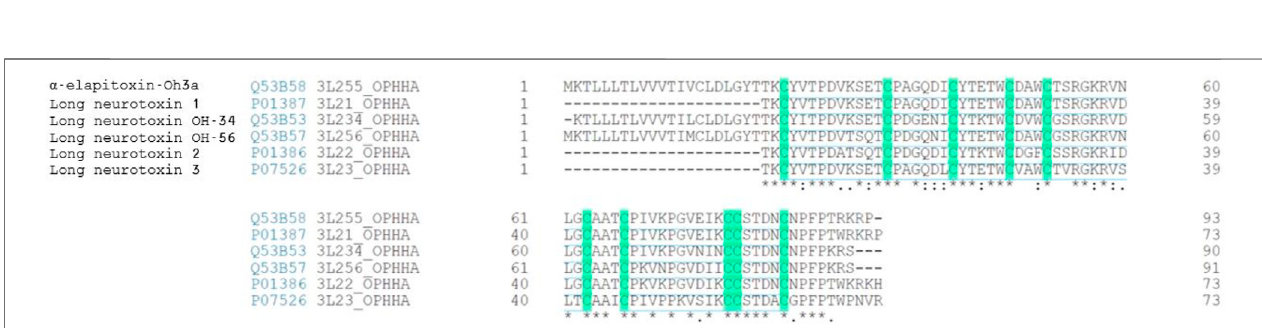
FIGURE4| Sequencealignment(fromBLASTsearch)of α -Elapitoxin-Oh3awithlong-chainalphaneurotoxinsfrom O.hannah venom.Highlightedaminoacidsare the 10 cysteine residues present in identical positions of all long-chain alpha neurotoxins that make the fi ve disul fi de bonds. Amino acids with (*) are fully conserved in all toxins, conserved amino acids with (.) are weakly similar properties group and amino acids with (:) are strongly similar properties group.